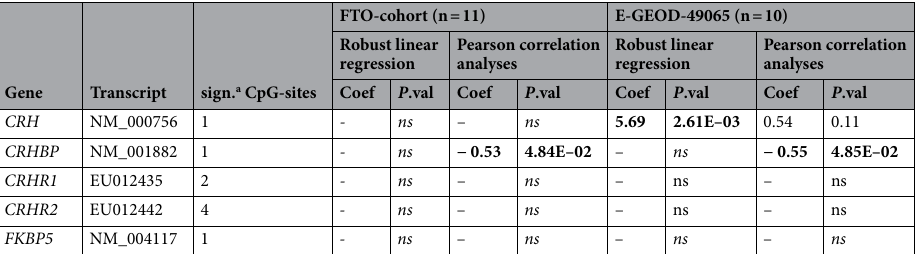
Table 4. Methylation/transcription correlations of CpG sites correlated with TSH/T4 (mE/nmol). The table lists CpG-sites located within the TSS2000 of HPA-axis genes that are significantly correlated with TSH/ T4-levels. Methylation probes belonging to the same transcript were first averaged and then investigated for a correlation with transcription in two separate cohorts of healthy controls (FTO-cohort and E-GEOD-49065 cohort). Methylation M-values were correlated with expression values inter-individually, by pearson correlations (assuming an inverse correlation) and robust linear regression models, respectively. Coef . regression coefficient; P .val, P